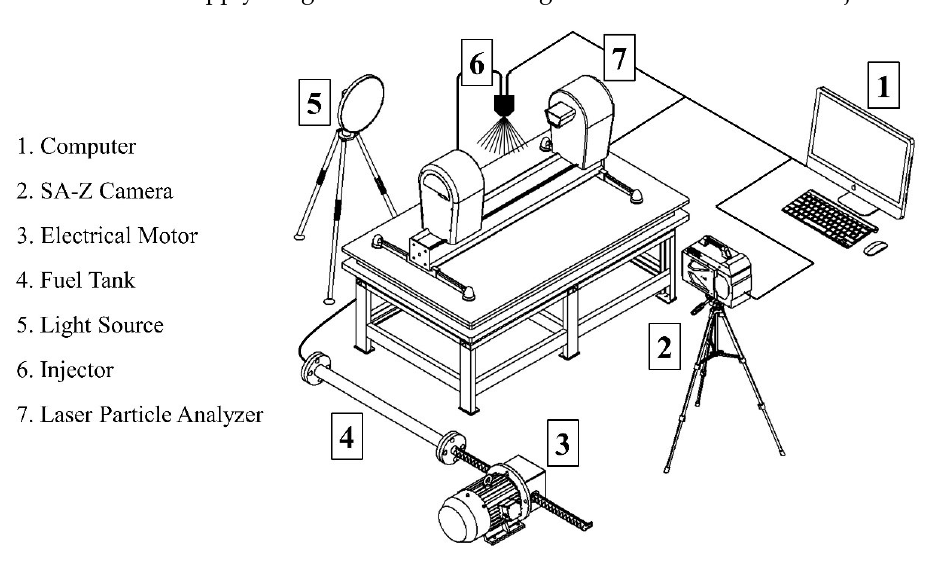
Figure 2. Experimental setup.